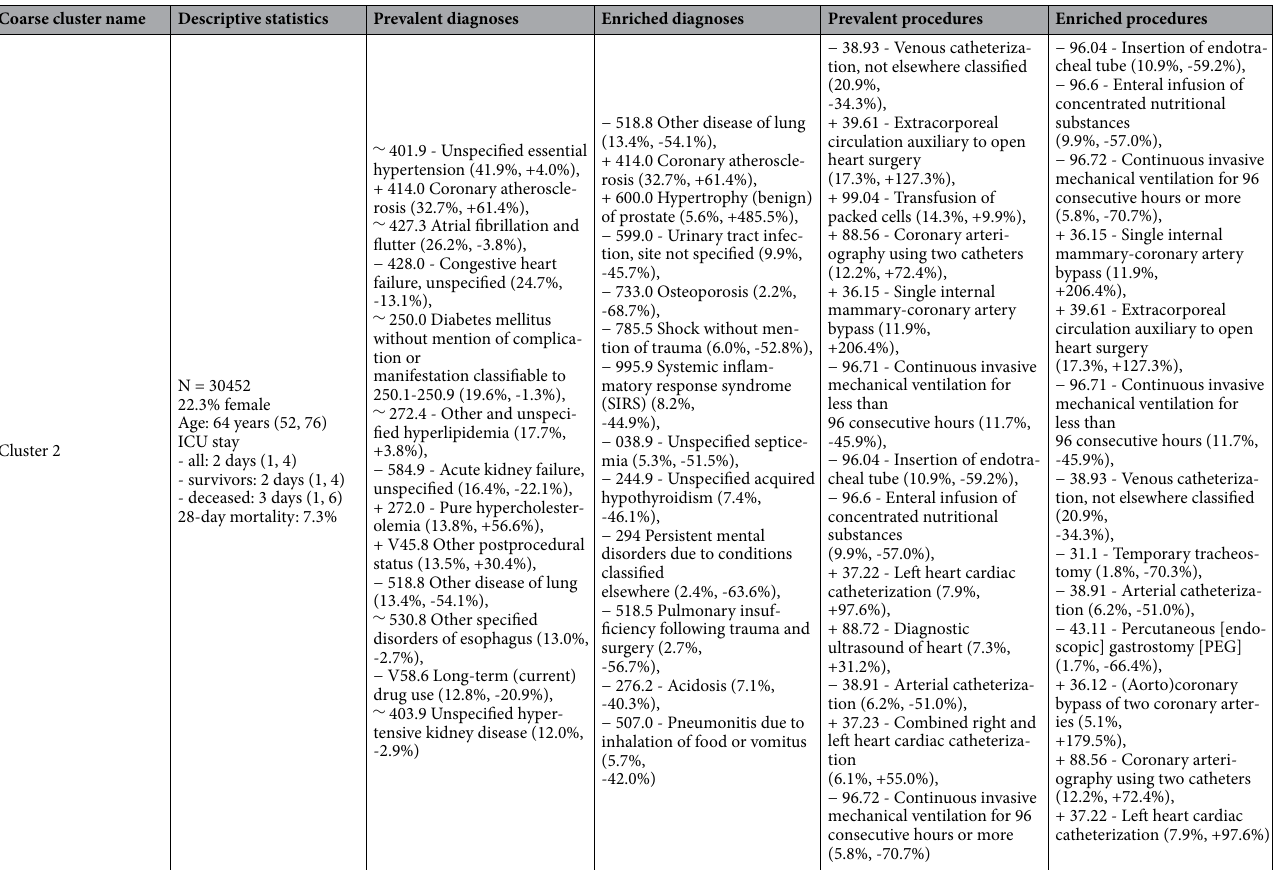
We do not supply information about the mortality or diagnoses to our model during training or inference. It is only used for evaluating clustering results. Thus, patterns observed in the clusters originate from the patients’ age, sex, and dynamic data. In the following, we first discuss the results of the coarse clustering (with k = 2 , Table 1) and then the pri- mary clustering ( k = 6 , Table 2). Note that in the table columns for enriched codes (diagnoses and procedures), only positively or negatively enriched codes are shown, not those that appear within the clusters with about the same frequency as within the cluster’s complement. We show bar plots comparing the ICD diagnosis category distribution between the clusters in Fig. 3 (for k = 2 ) and Fig. 4 ( k = 6 ). For the primary clustering, we offer a tornado plot showing the differences in ICD disease category distribution between clusters (Fig. 5). These figures enable a quick visual comparison between diagnosis distribution in clusters. They were created by iterating over all patients within a cluster, examining each of their ICD diagnoses, and then counting the respective ICD top- level categories (e.g., 460–519: Diseases of the Respiratory System , which becomes “Lung” in the figures). Every diagnosis is counted, even multiple ones for the same patient. Since the coarse clustering splits the population into only two groups, the two resulting groups of patients are relatively large and still quite heterogeneous. However, it is noteworthy that Cluster 1 and 2 differ mainly in terms of the distribution of sex ( 78% female vs. 22% female) and mortality ( 23.5% vs. 7.3% ). In contrast, the length of stay on ICU and age distribution are relatively similar between the two clusters. As expected from the considerably different mortality rates alone, Cluster 1, i.e., the cluster with the higher mortality rate, was more likely to contain acute diagnoses, which are generally associated with greater severity of illness. These enriched